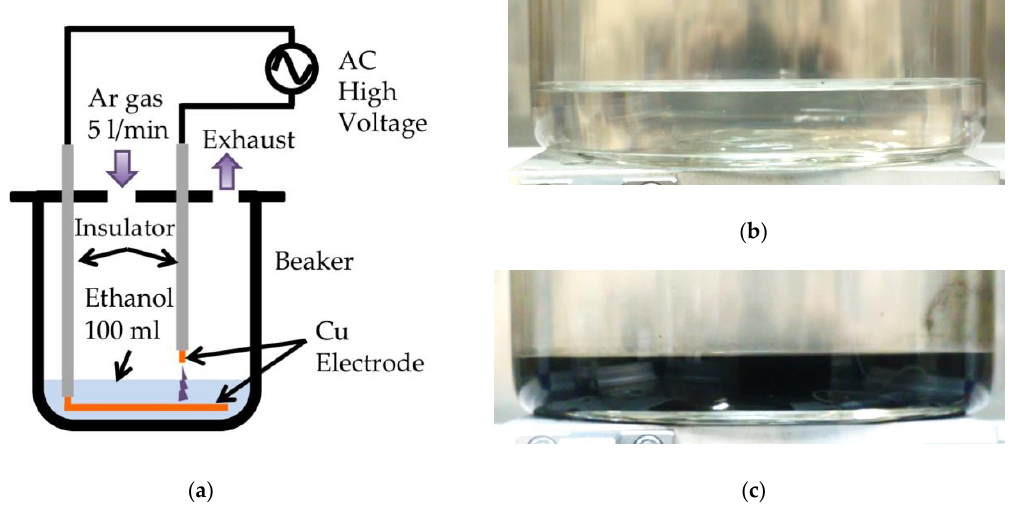
Figure 1. A schematic diagram of an in-liquid plasma device ( a ), liquid before the plasma treatment ( b ), and liquid after the plasma treatment ( c